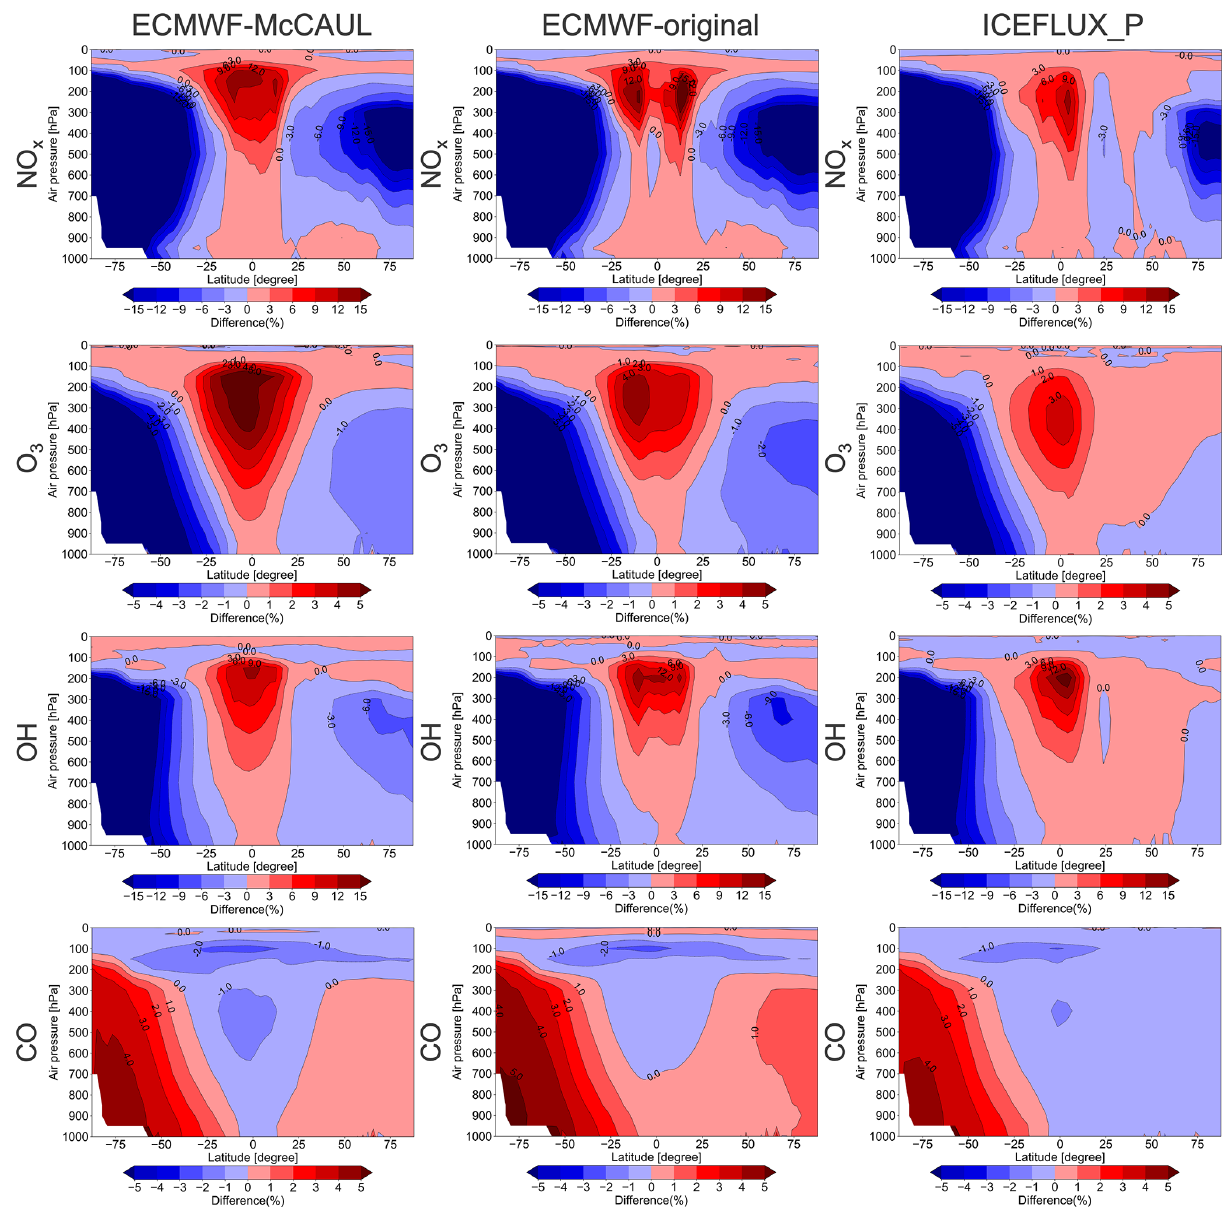
Figure 11. Effects of the ECMWF-McCAUL scheme, original ECMWF scheme, and ICEFLUX_P scheme on the atmospheric chemical fields (NO x , O 3 , OH, CO) relative to the CTH scheme on the zonal mean